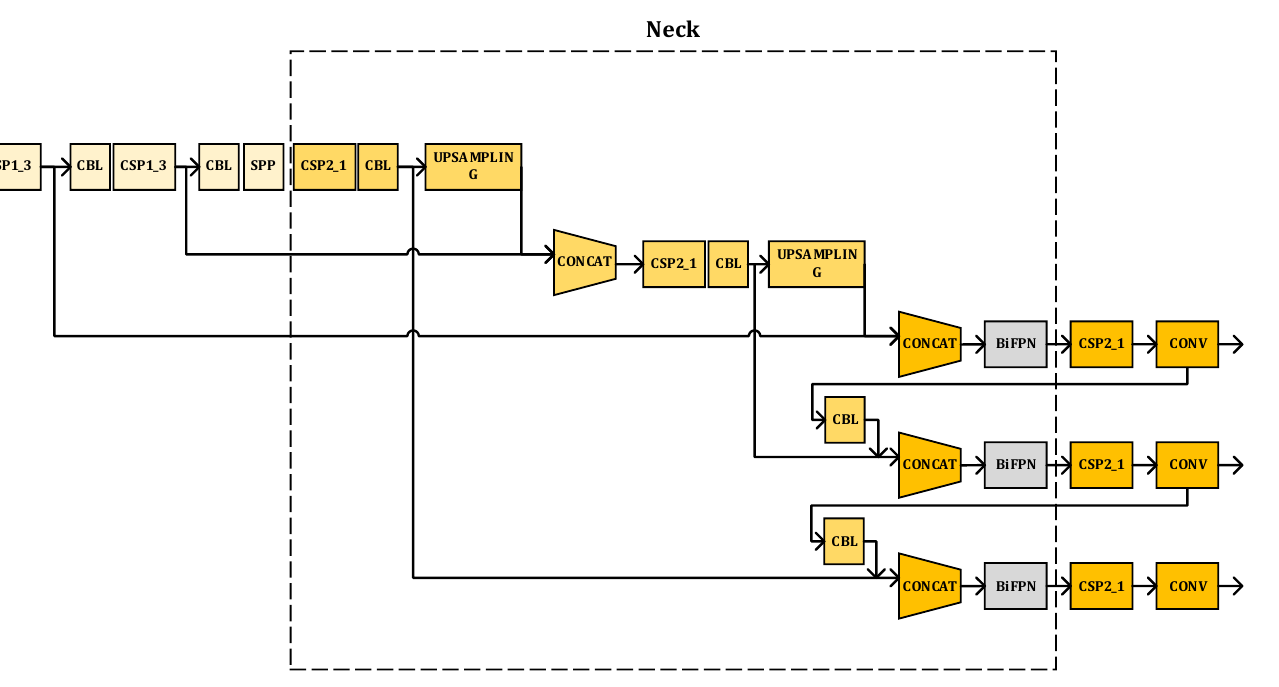
Figure 7. Schematic diagram of the improved neck network structure.